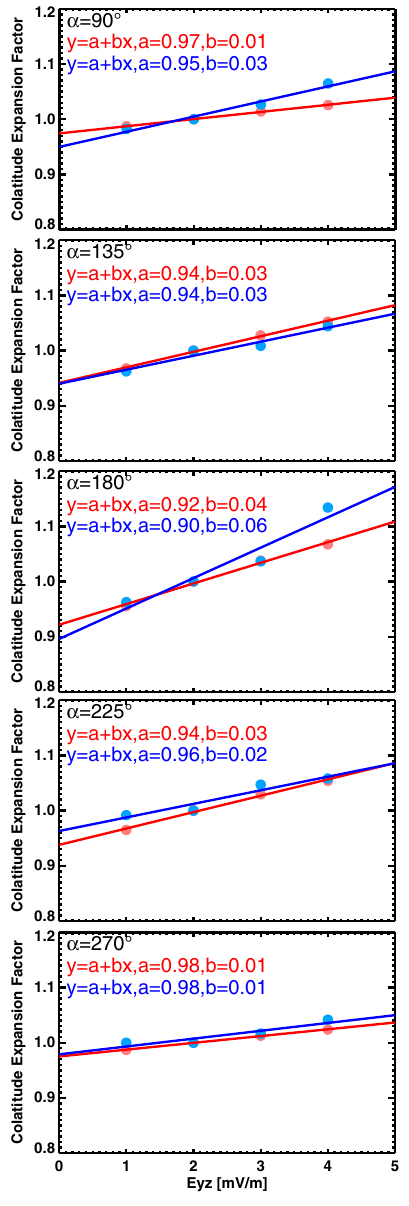
Fig. 6. Dependence of the colatitude expansion of the large-scale Birkeland current distribution on solar wind electric field, E yz , and IMF clock angle, α , for the Iridium observations (blue dots) and the BATS-R-US plus RCM simulations (red dots). The lines of the respective color represent the linear least-squares fit functions noted at the top of each